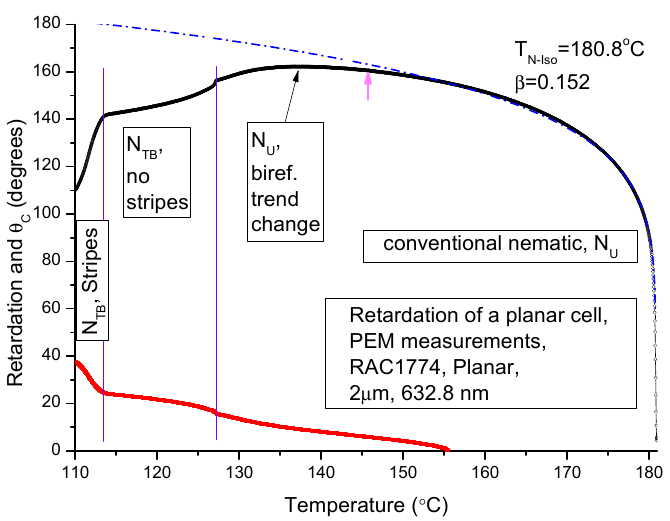
Figure 5. Optical retardation for the fluorinated dimer M2 (DTC3C11) plotted as a function of temperature in both N and N TB phases. ∆ n is ~3.6% lower than its maximum value in the N phase, and it is ~ 11% lower than the value obtained via power-law extrapolation. Black circles: the experimental data on optical retardation, blue-dash dotted line is the power-law extrapolation, the magenta arrow: the lower boundary of the data used for fitting, red squares represent the calculated θ c . The vertical lines are drawn for temperatures under discussion.